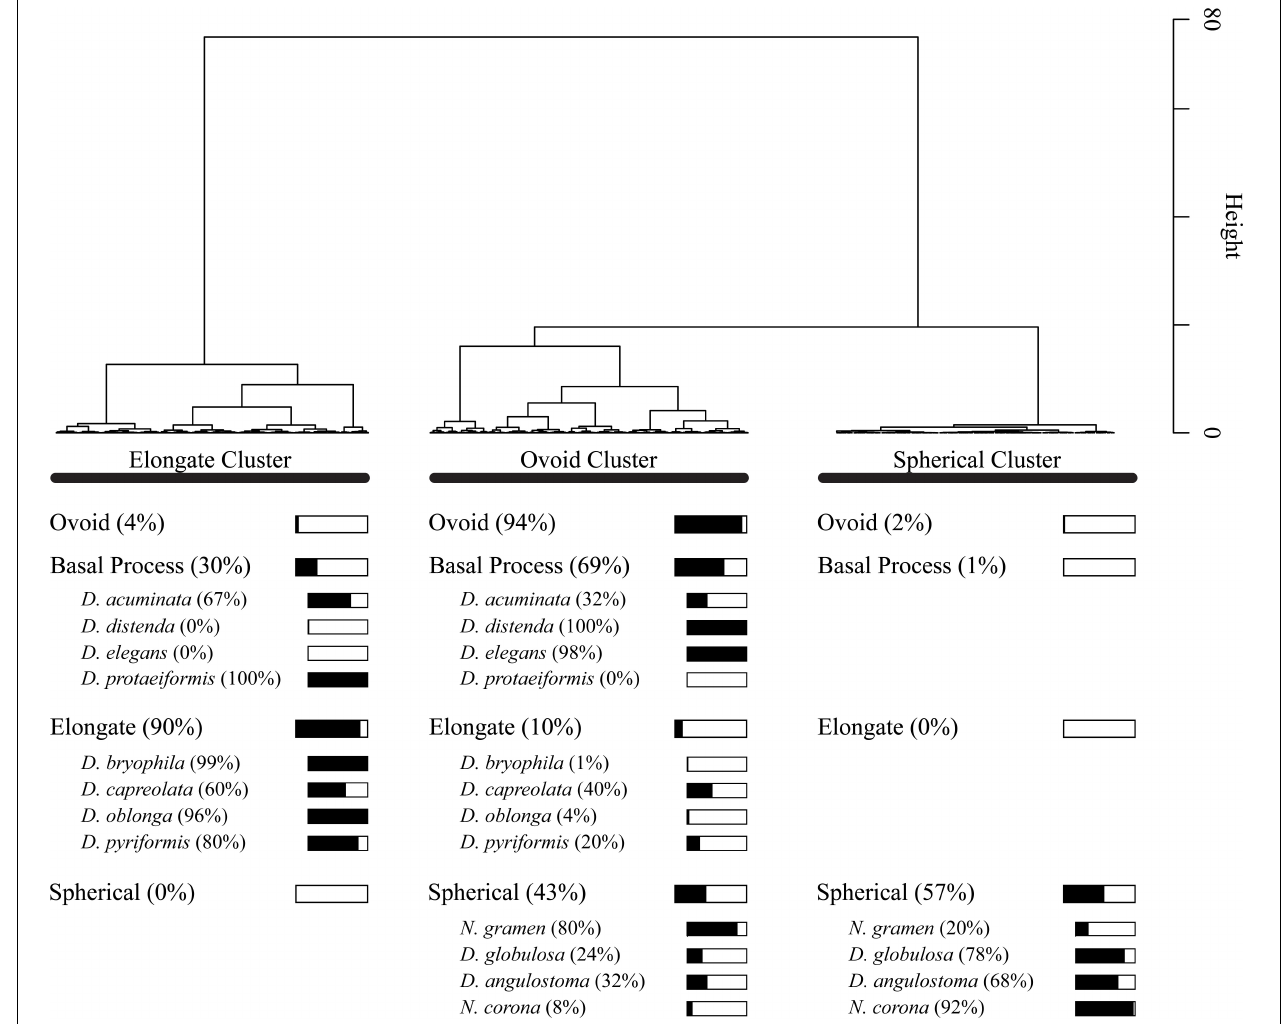
FIGURE 7 | Dendrogram showing Wards cluster analysis of Principal Component Analysis PC1 and PC2 scores for all 1503 specimens. For each shape group, we show what percentage of the specimens are present within the cluster groups. For example, 57% of specimens in the spherical shape group are found in the Spherical